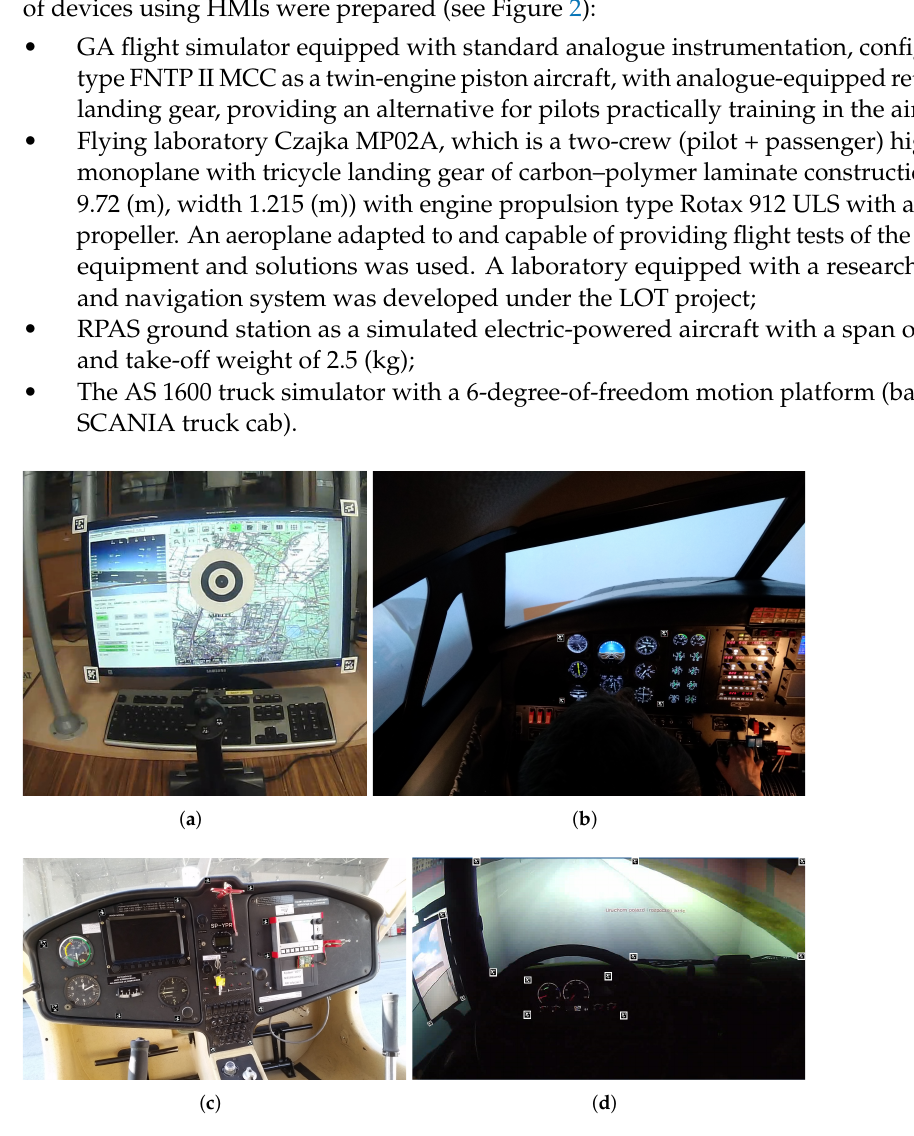
Figure 2. Observer attention recording and analysis stand ( a ) RPAS, ( b ) GA simulator (cockpit view), ( c ) flying lab (cockpit view), ( d ) truck simulator (cockpit